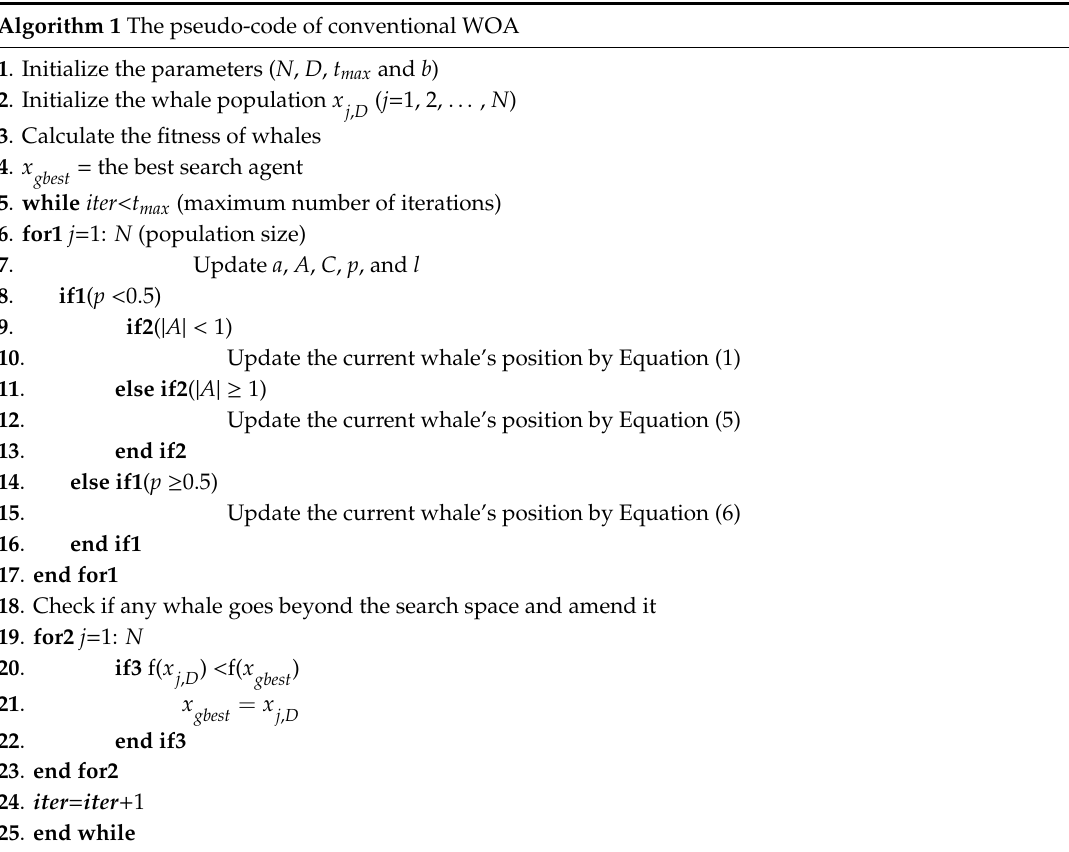
Algorithm 1 The pseudo-code of conventional